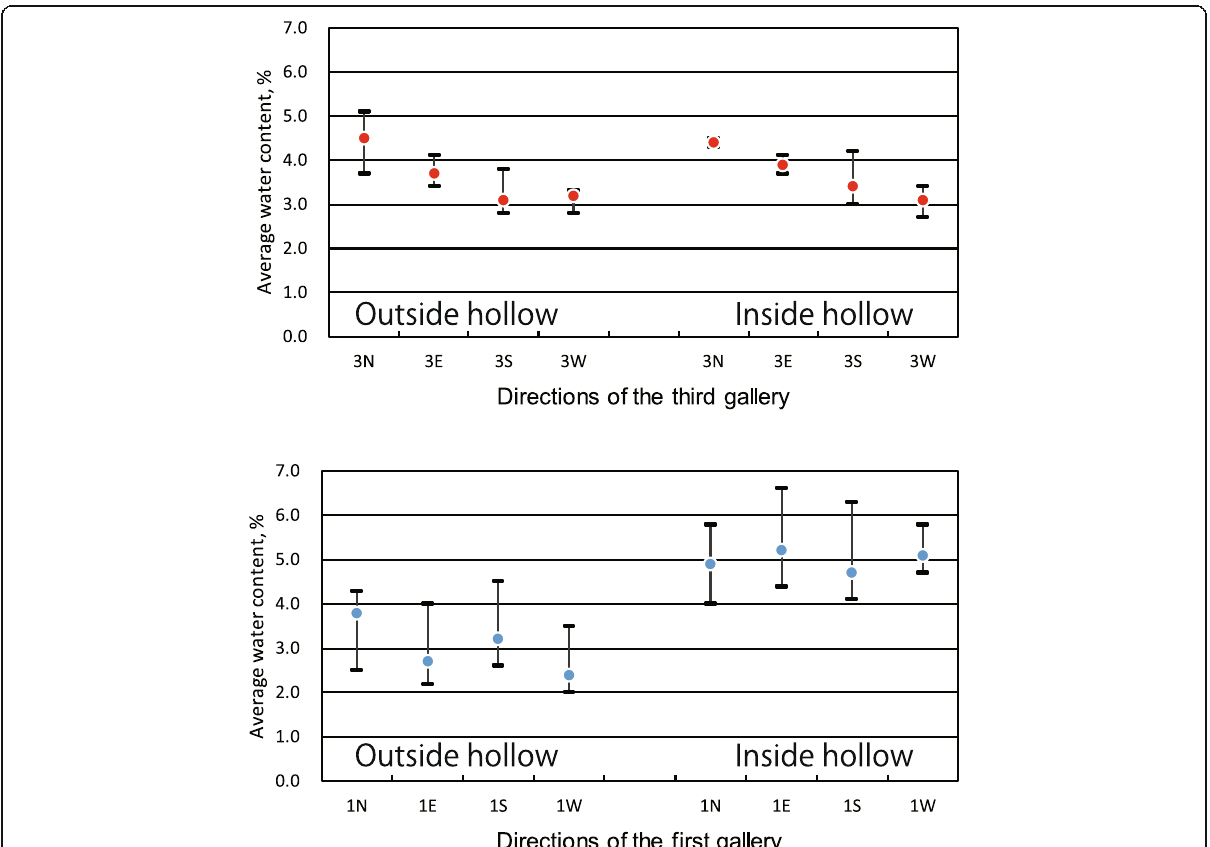
Table 2 Statics of temperature and relative humidity of the first and third galleries between 2011 and 2015. Italics mean maximum values of the air temperature and relative humidity Gallery and direction First gallery